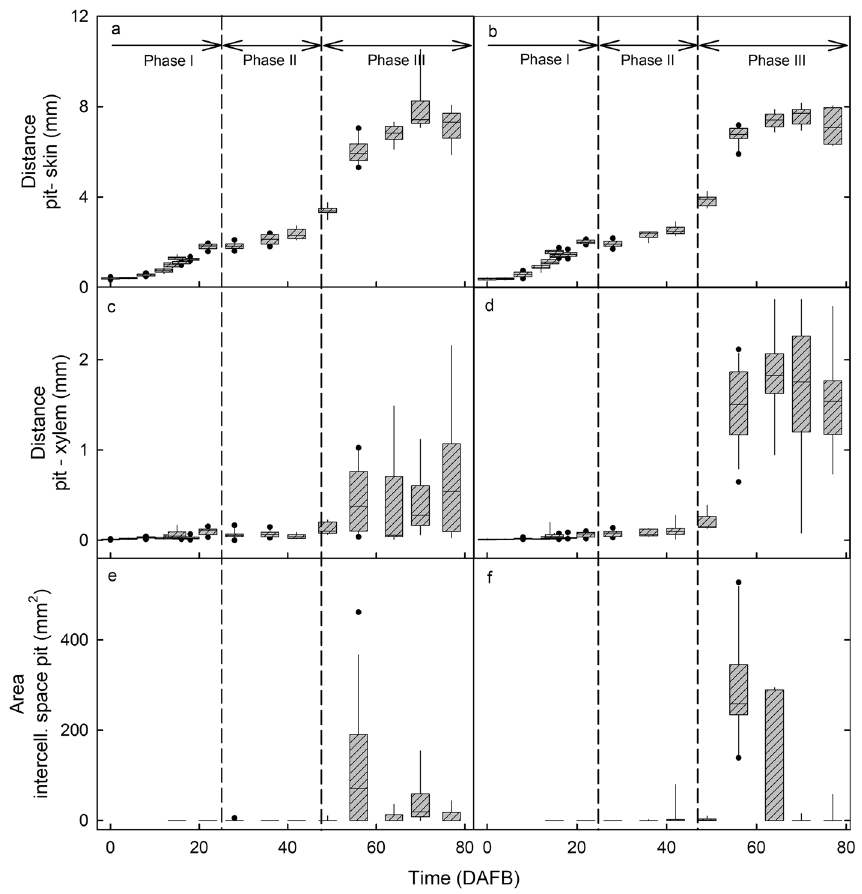
Figure 3. Developmental time course of changes in distances and cross-sectional areas of the median bundle in the cheek region ( a, c, e ) and the lateral bundles in the shoulder regions ( b, d, f ). ( a, b ) Distance between pit and skin. ( c, d ) Distance between pit and xylem. ( e, f ) Areas of the intercellular spaces around the pit. The x -axis scale in days after full bloom (DAFB). The box represents the 25th and 75th percentiles, the horizontal line in the box the median, and the whiskers the 5th and 95th percentiles. Individual symbols beyond the whiskers are